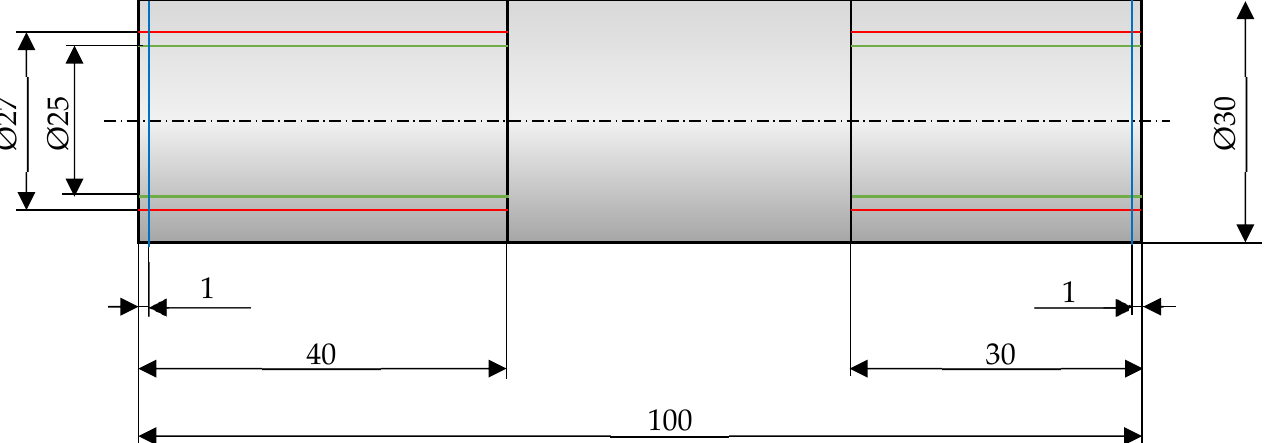
Figure 1. Scheme of machining of the steel bar according to cutting parameters given in Table 4. Dimensions are given in millimeters.